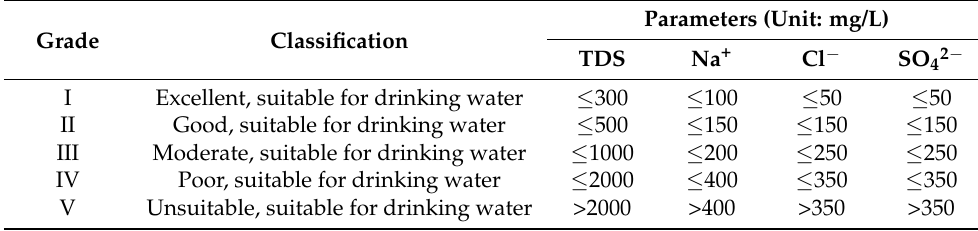
Table 1. Standard for classification of groundwater quality in China (GB/T